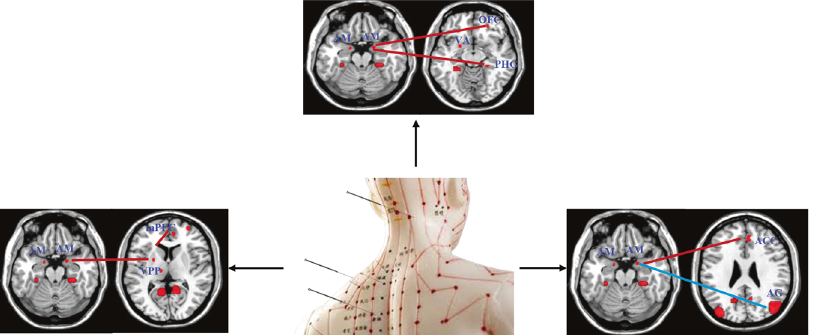
Fig. 7 Changes of brain functional connectome in MDD patients in response to acupuncture treatment. Blue lines indicated decreased functional connectivity (FC) after treatment and red lines indicated increased FC after treatment. AM, Amygdala; mPFC, Medial prefrontal cortex; VPP, Ventral prefrontal putamen; ACC, Anterior cingulate cortex; AG, Angular gyrus; PHG, Parahippocampal gyrus; OFC, Orbitofrontal cortex.